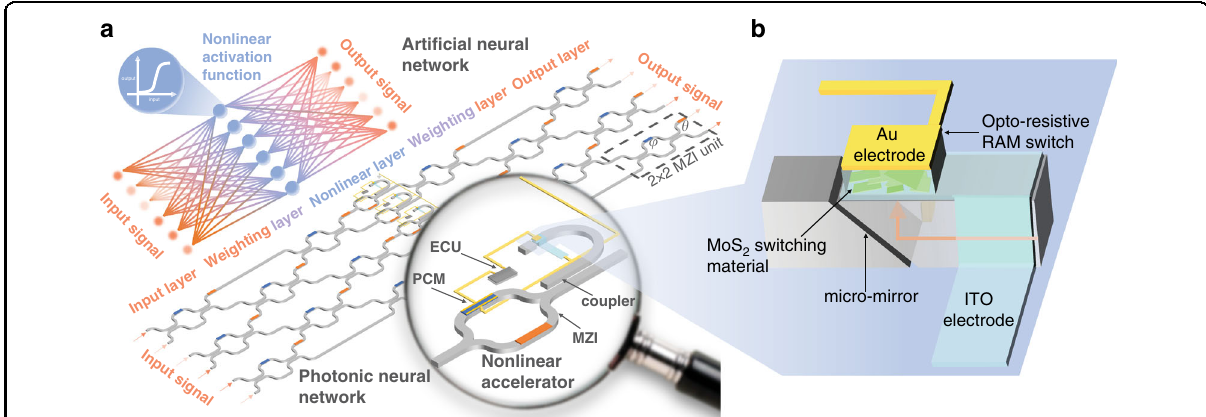
Fig. 1 Photonic neural network architecture. a The schematic structure of photonic neural network integrated with nonlinear accelerator, which achieves nonlinear activation functions. b The schematic of the Opto-Resistive RAM Switch. (ECU Electrical Control Unit, PCM Phase Change Material, MZI Mach – Zehnder